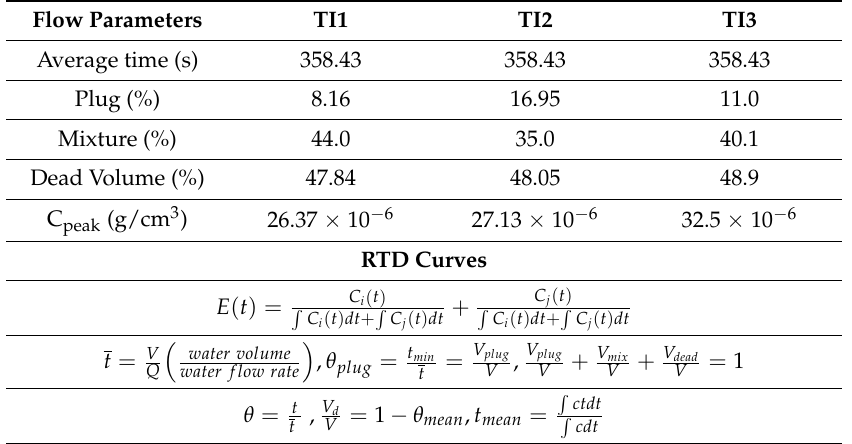
Table 2. Experimental averaged flow parameters from the residence time distribution (RTD)